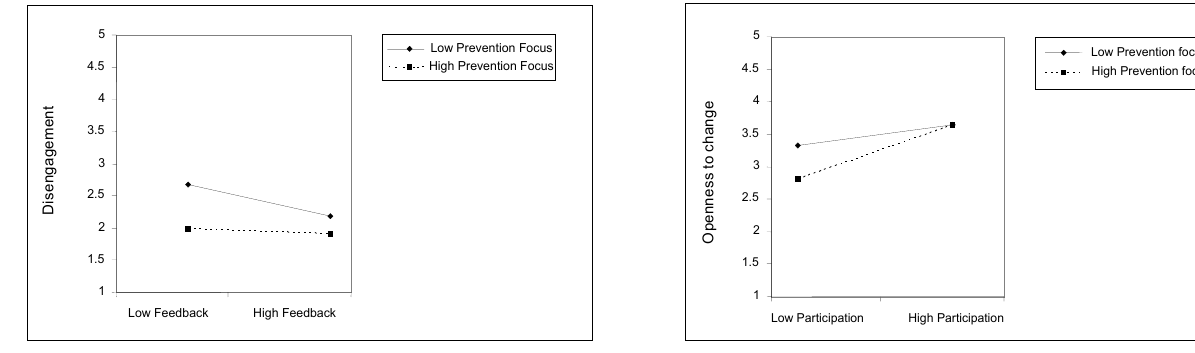
FIGURE 3 Prevention focus moderating the relationship between feedback and disengagement in sample 2